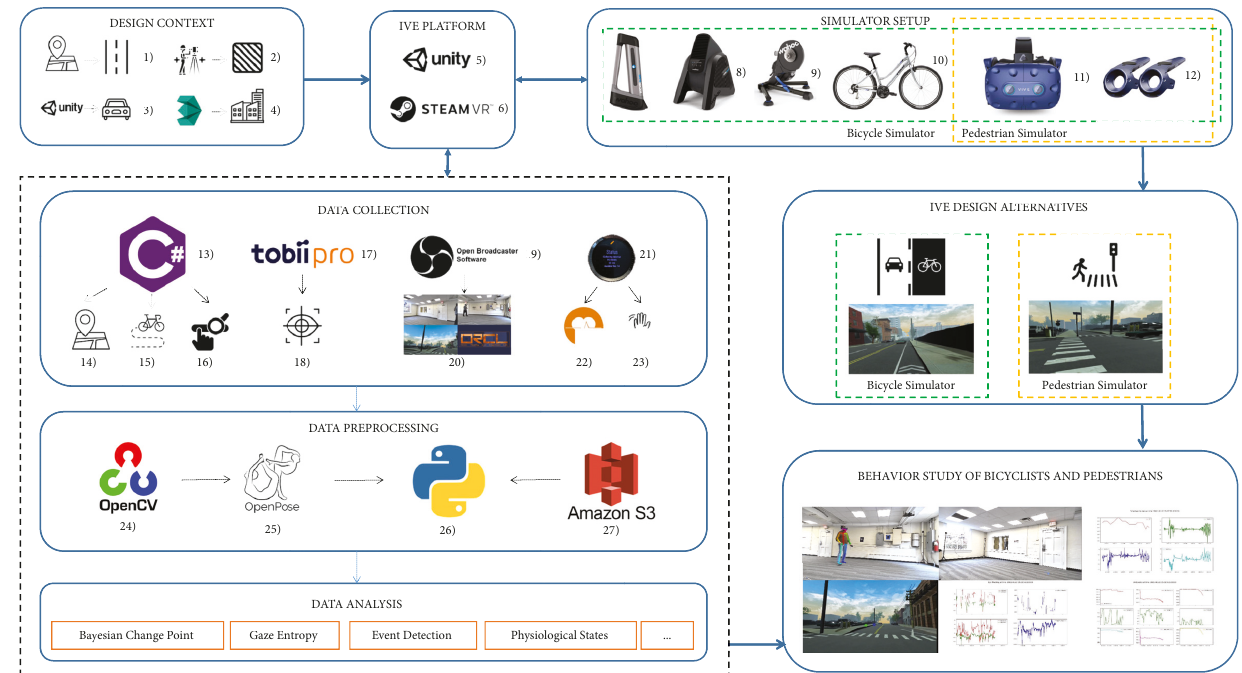
Figure 1: System architecture of the ORCLSim framework. Design context: (1) road geometry information from Google Maps; (2) road texture from real-world measurement; (3) vehicle modeling and traffic simulation in Unity; (4) buildings modeling from 3DMax. IVE platform: (5) Unity: 3D gaming engine; (6) SteamVR: integrating hardware with Unity. Simulator setup: (7) Wahoo Kickr Climb: physical grade changes; (8) Wahoo Kickr headwind: headwind simulation by speed; (9) Wahoo Kickr Smart Trainer+ANT+: biking dynamics simulation; (10) Trek Verve physical bike; (11) HTC VIVE Pro Eye: VR headset with eye tracking; (12) controllers: steering and braking of the bike and pedestrian’s interactions with the environment. Data collection: (13) C# scripts in Unity to record (14) position, (15) cycling performance, and (16) pedestrian’s interactions (touch, click, or press); (17) Tobii Pro Unity API collects; (18) eye tracking data; (19)